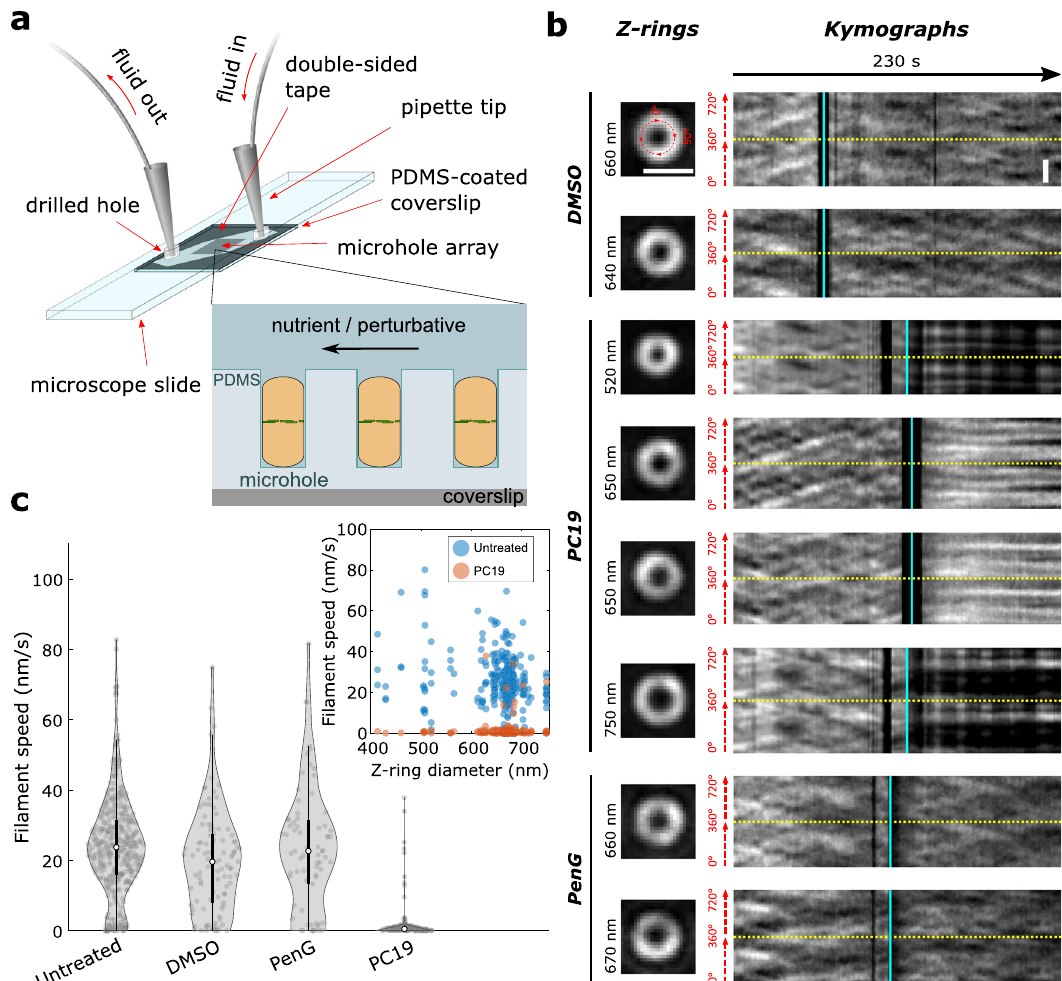
Fig. 2 PC190723 arrests cellular FtsZ treadmilling within seconds across all stages of constriction. a Schematic of micro fl uidic VerCINI. Rod-shaped cells are con fi ned in open-topped microholes in a thin layer of PDMS atop a microscope coverslip as solutions fl ow over them. The fl ow channel is formed from a cut piece of double-sided tape sandwiched between the PDMS layer and a microscope cover slide with drilled holes to allow inlet and outlet tubes. b Representative images of septa and associated kymographs of FtsZ-GFP (SH130) dynamics in vertically-immobilised cells during rapid treatment with either DMSO (top), PC19 (middle) or PenG (bottom) at multiple septal diameters. Images of septa show the fi rst frame in kymographs ( t = 0 s). Kymographs were obtained by fi tting septal images to circles and plotting intensity values around the circumference of the cell for each frame of the time- lapse (1 frame/s). Two full revolutions around the cell (0 – 720 o ) are plotted side-by-side in each kymograph to resolve fi lament trajectories that pass 0 o / 360 o , separated by yellow dotted lines. Cyan lines show arrival time of media containing DMSO, PC19 or PenG. Black bands around time of treatment resulted from a loss of focus during fl uid exchange. Fluctuations in intensity for two septa post-PC19 treatment (750 and 520nm diameter septa) resulted from manual refocusing during imaging. Scale bars: 1000 nm. All images same magni fi cation. c Violin plots of FtsZ treadmilling speeds pre- and post- treatment measured from kymographs. White circles, median; thick black lines, interquartile range; thin black lines, 1.5x interquartile range. DABEST plots of effect size can be found in Supplementary Fig. 12. Inset: FtsZ treadmilling speed distributions for untreated (blue circles) and PC19-treated (red circles) cells from violin plots separated by septal diameter. Source data for this fi gure are provided as a source data fi